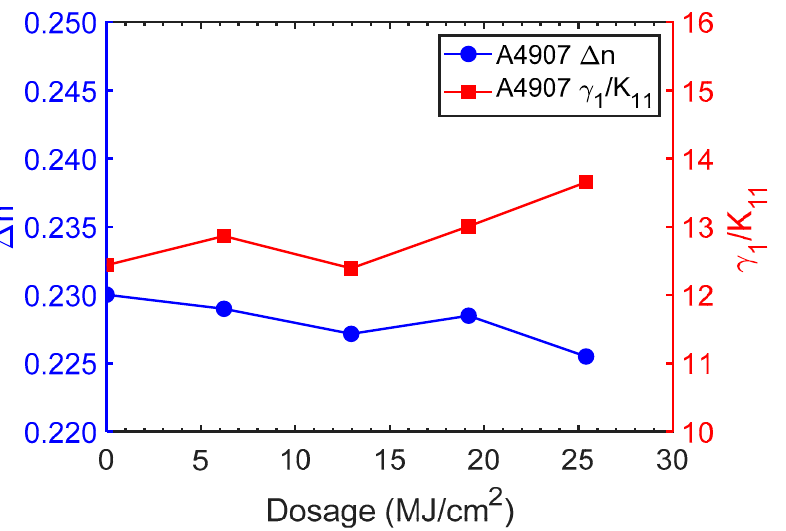
Figure 7. Measured photostability of A4907 with a blue laser at λ = 465 nm at 22 °C. Probing laser λ = 633 nm.